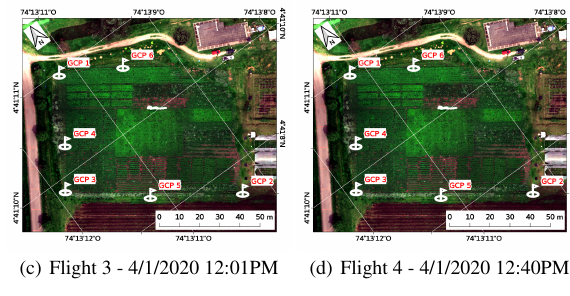
Figure 4. GCPs and CPs scheme. a) December 28, 2019 at